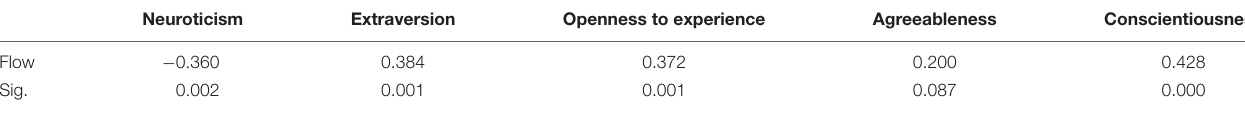
TABLE 1 | Correlations between the teachers’ flow state and the big five